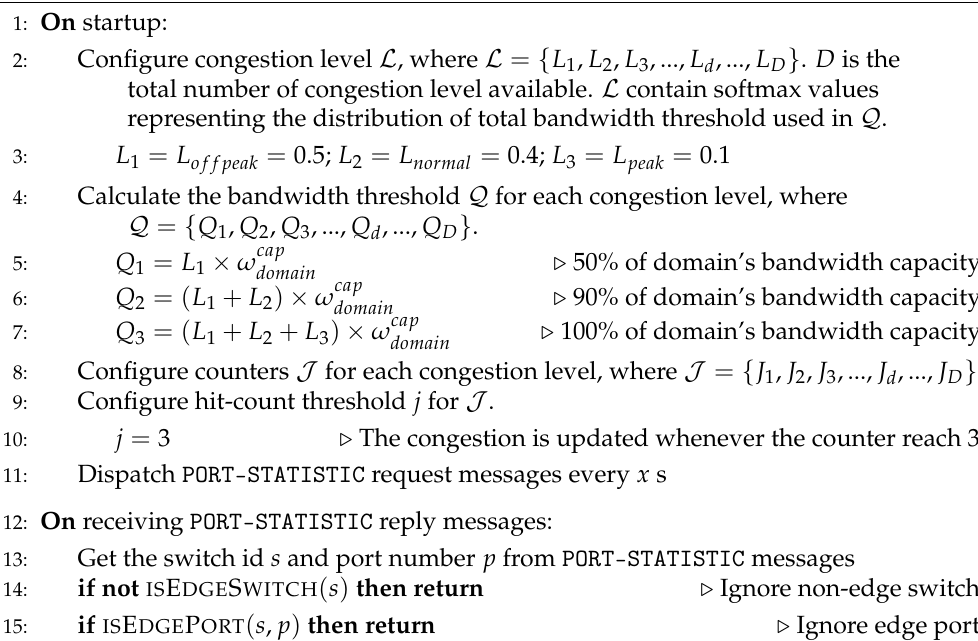
Algorithm 4 The density tracker module’s